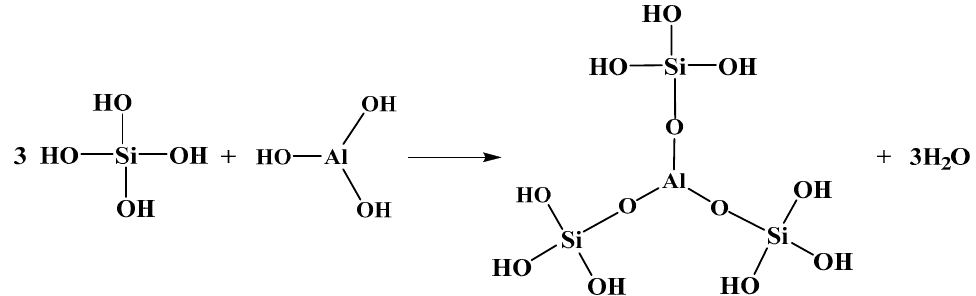
Figure 8. The dehydration condensation reaction between Si(OH) 4 and Al(OH) 3 .